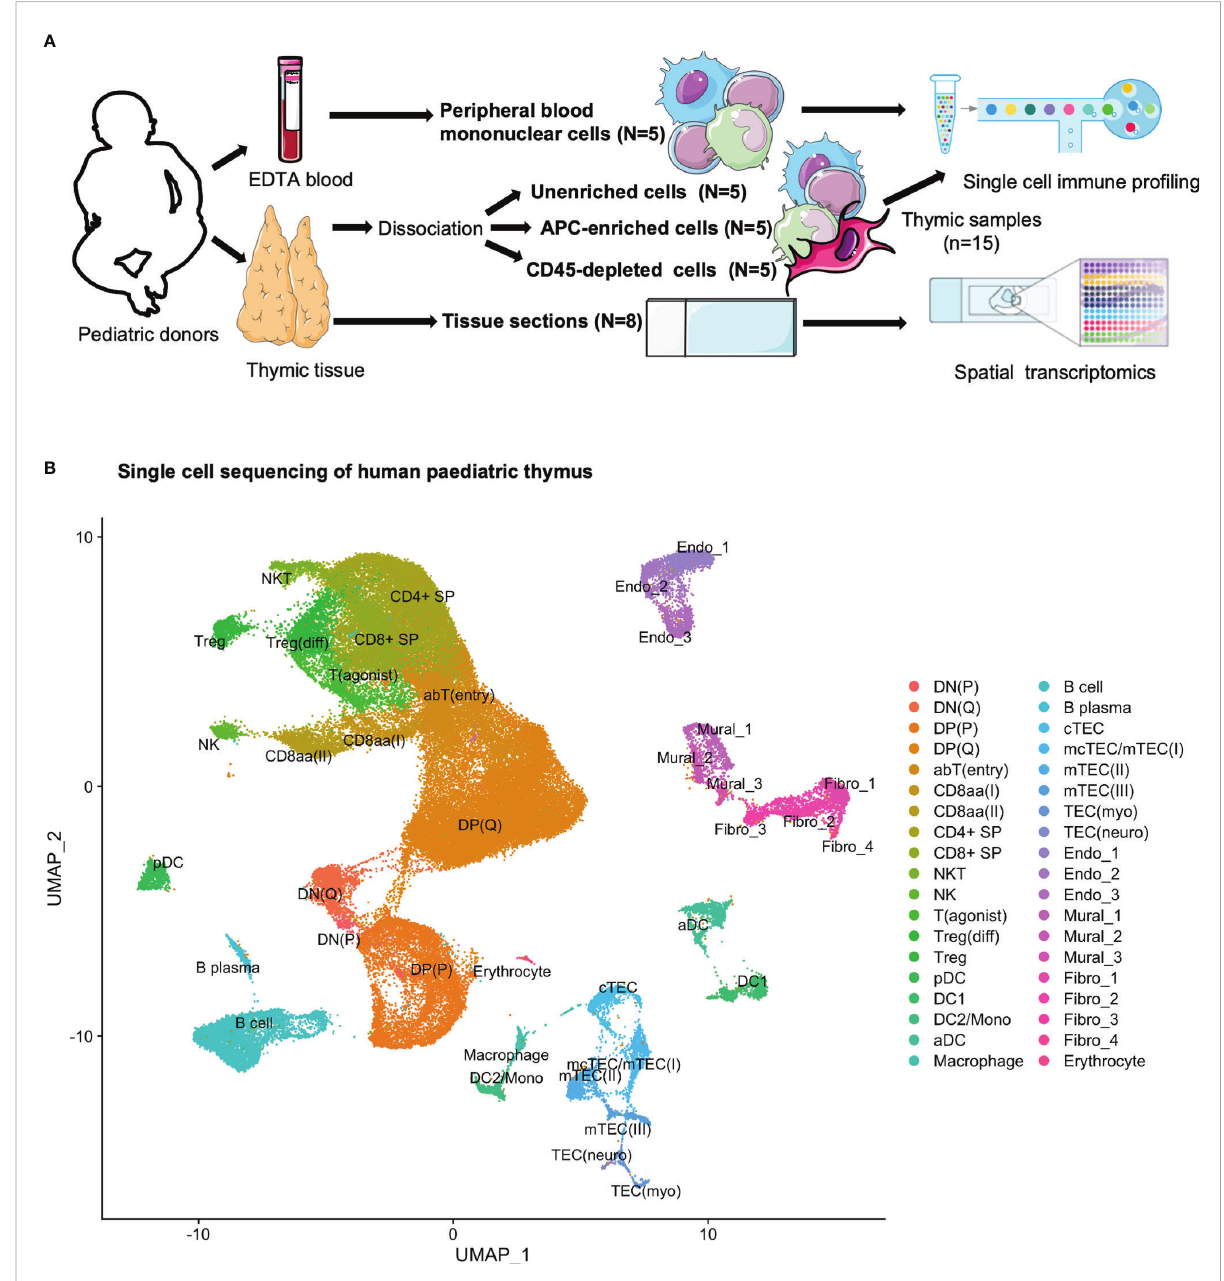
FIGURE 1 Multimodal pro fi ling of human paediatric thymus. (A) Experimental set-up. Tissue was subjected to dissociation (N=5) or snap frozen (N=8) for sectioning. From donors where tissue was to be dissociated, EDTA blood was also collected. CITE-seq was performed for PBMCs (n=5) and thymic cells (n=15) at three separate stages of dissociation: 1. unenriched, 2. APC enriched, and 3. CD45-depleted. Tissue sections were used for spatial transcriptomics. (B) UMAP of 83 847 cells colour-coded for the cell types identi fi ed in